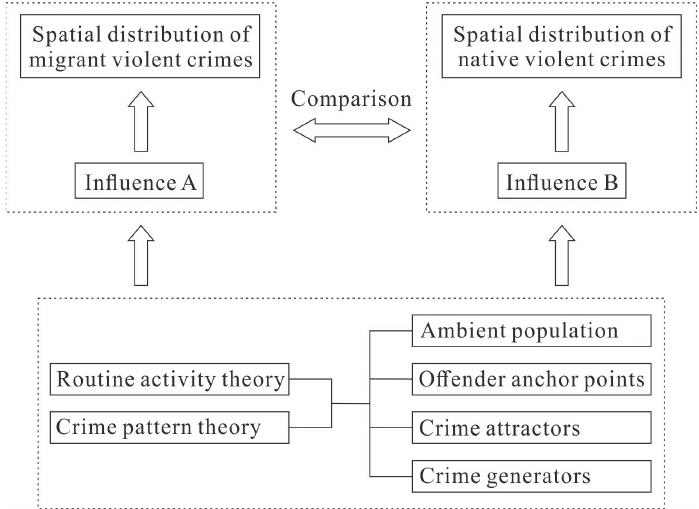
Figure 1. Conceptual framework for comparing migrant and native violent crimes.